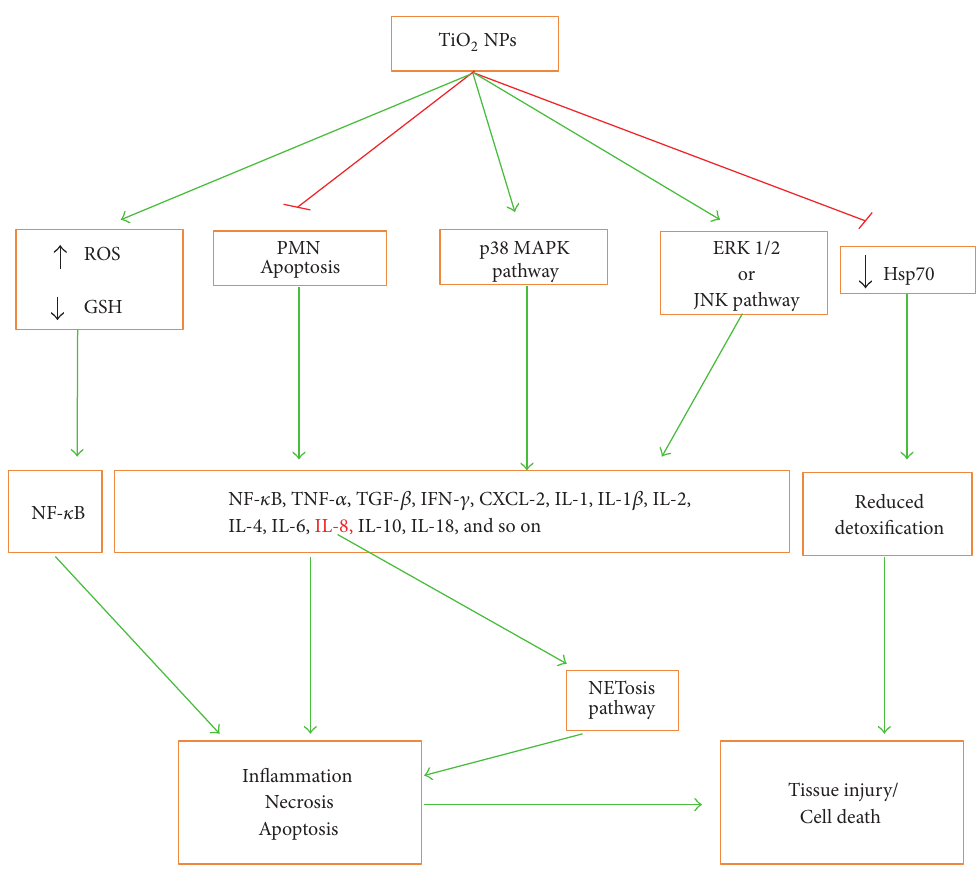
Figure 4: Nano-TiO 2 -induced tissue injury and inflammation. These NPs cause elevation of ROS, decline of GSH levels, inhibition of PMN apoptosis, and tyrosine phosphorylation of p38MAPK and ERK1/2 or JNK. All these induce the production of different inflammatory cytokines that in turn lead to inflammation and consequent necrosis or apoptosis mechanism of cell death. Decreased detoxification due to CYP1A and HSP70 decline also leads to tissue injury or cell